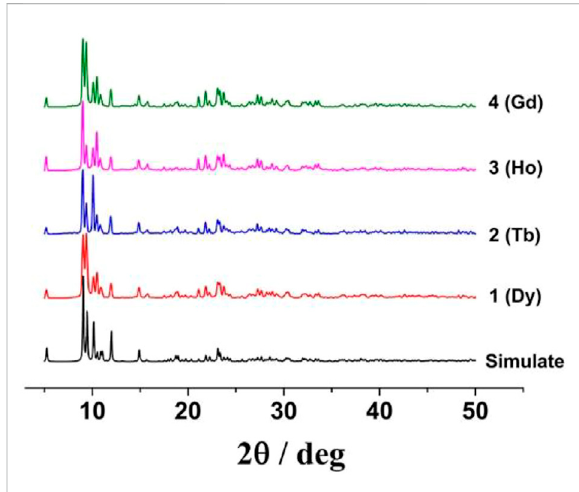
FIGURE 1 Experimental and simulated PXRD patterns of all complexes.